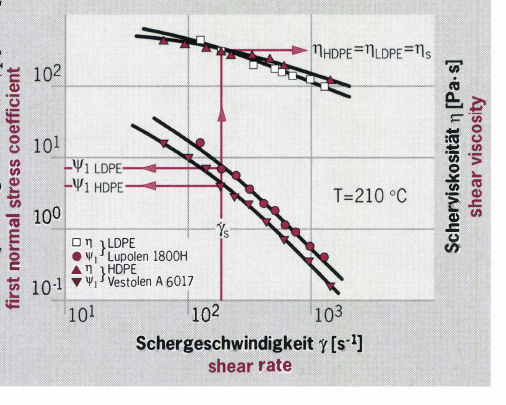
Abb. 6: Vergleich der ersten Normalspannungsdifferenz gegen die Schubspannung von zwei Polyethylen­ schmelzen (LOPE, Lupolen 1800 H und HOPE, Vestolen A 6017, Fig. 6: Comparison of the first normal stress difference with the shear stress of two polyethylene melts (LOPE, Lupolen 1800 H and HOPE, Vestolen A 6017 at 210